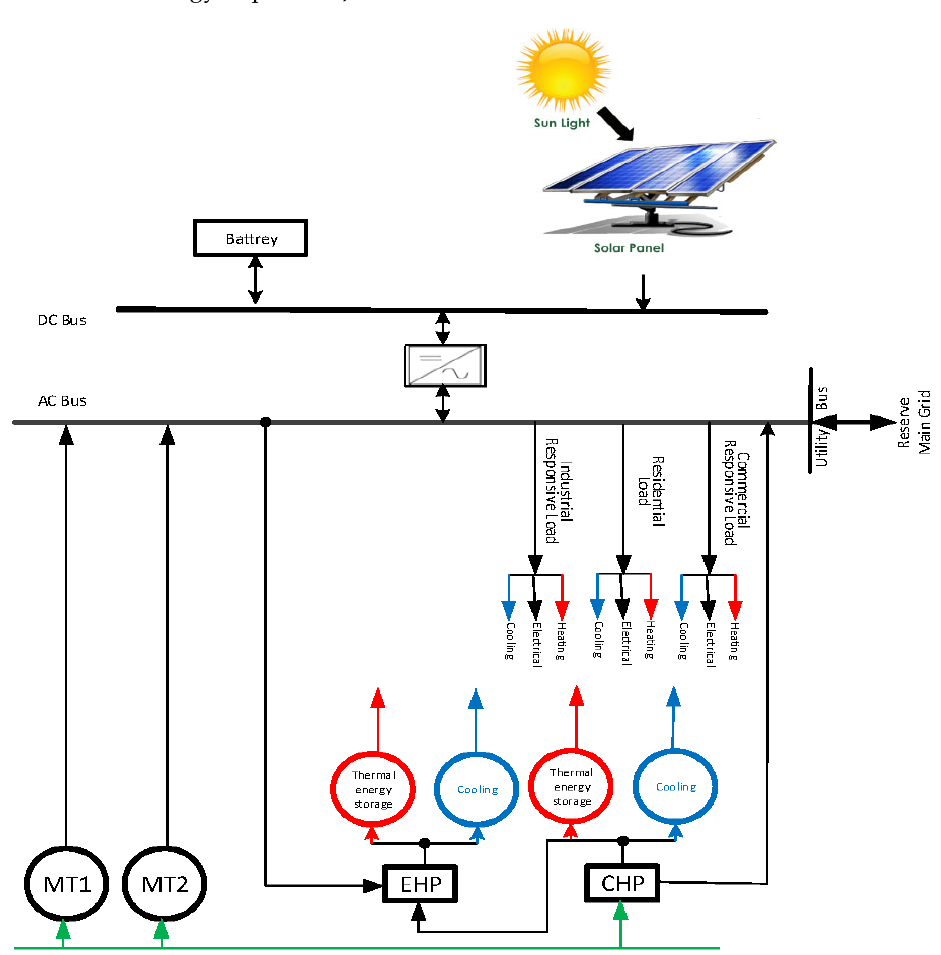
Figure 1. Proposed energy hub model and energy flow.